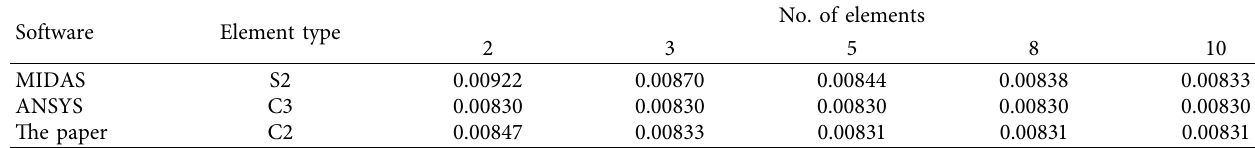
Table 2: θ y , the maximum rotation of the quarter arc beam in the y -direction.